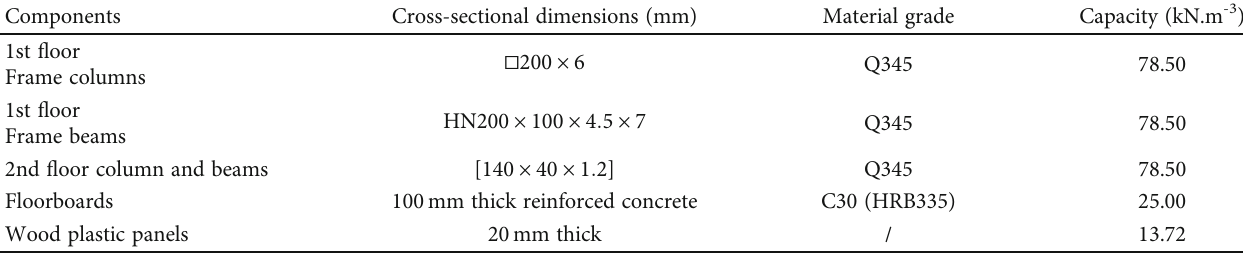
Table 1: The component materials of the light steel-wood-plastic residential